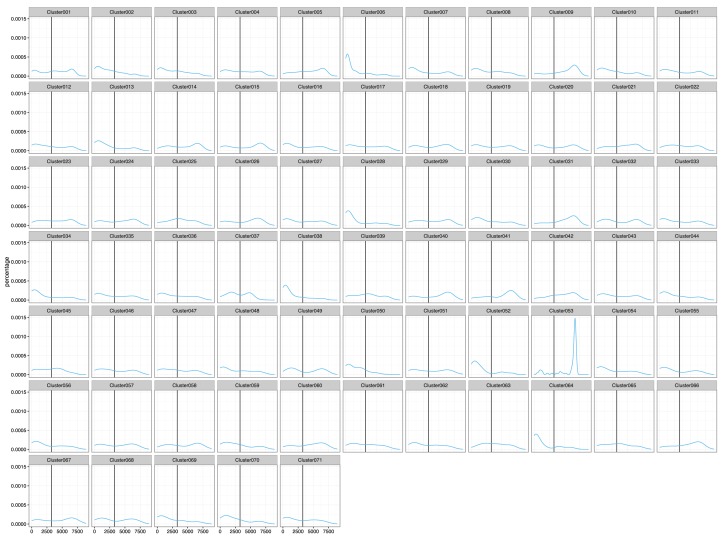
Density of days in contact with SDCC for each cluster.Density diagram of days an individual has been connected to Steno Diabetes Center Copenhagen (SDCC) divided by each cluster. The black line indicates the mean of SDCC connection time for the entire cohort. Some clusters for example Cluster1, show two peaks indicating that there are at least two groups of individuals in a cluster; one connected to SDCC more than the average cohort, and one connected less.